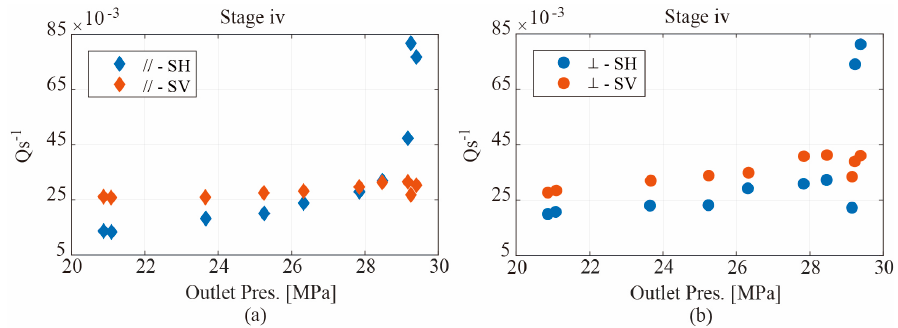
Figure 14. Comparison of measured (cid:1843) //(cid:2879)(cid:3020)(cid:2879)(cid:2869) ( a ) and (cid:1843) (cid:2884)(cid:2879)(cid:3020)(cid:2879)(cid:2869) ( b ) in stage iv, respectively.